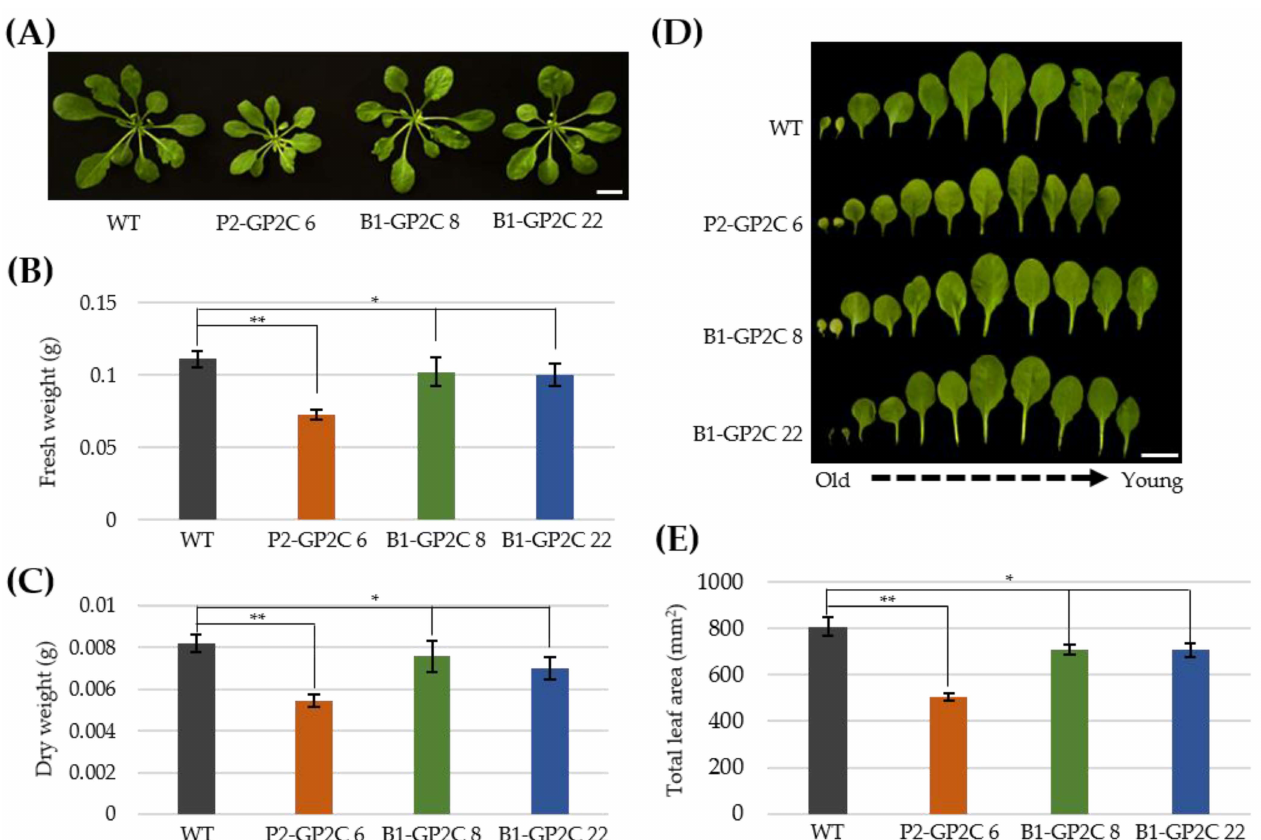
Figure 4. Vegetative growth phenotypes in P2-GP2C and B1-GP2C plants. ( A – E ) Comparisons of the rosette leaf growth ( A ), fresh weight ( B ), dry weight ( C ), leaf growth ( D ), and total leaf area ( E ) of 6-week-old WT, P2-GP2C, and B1-GP2C plants. Scale bars = 1 cm. Data represent the mean ± SE ( n = 15 in B and C, n = 10 in E). Asterisks indicate statistical differences detected by Student’s t -test (* not significant p > 0.05; ** significant p <